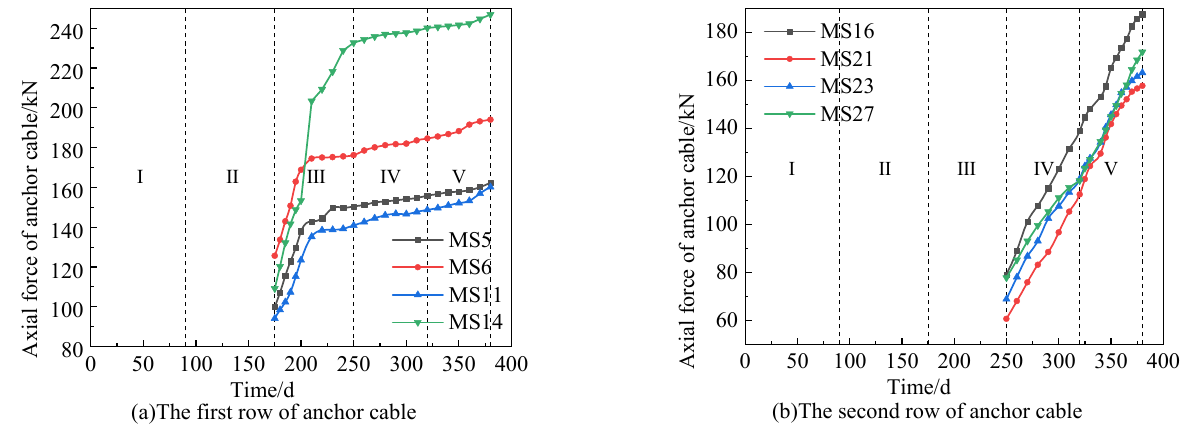
Figure 13. Variation curve of the axial force of the anchor cable.